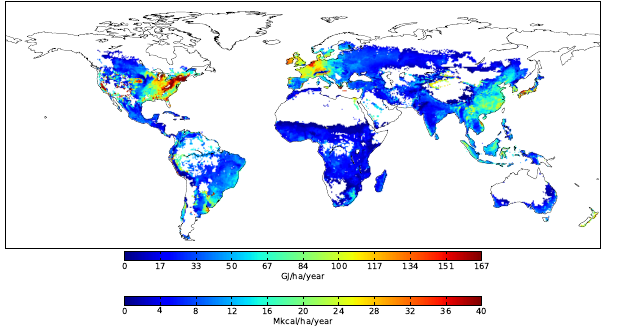
Fig. 6. Difference between potential and actual yield of crops mod- elled in the LPJmL model (dynamic crops), average over the 1999– 2003